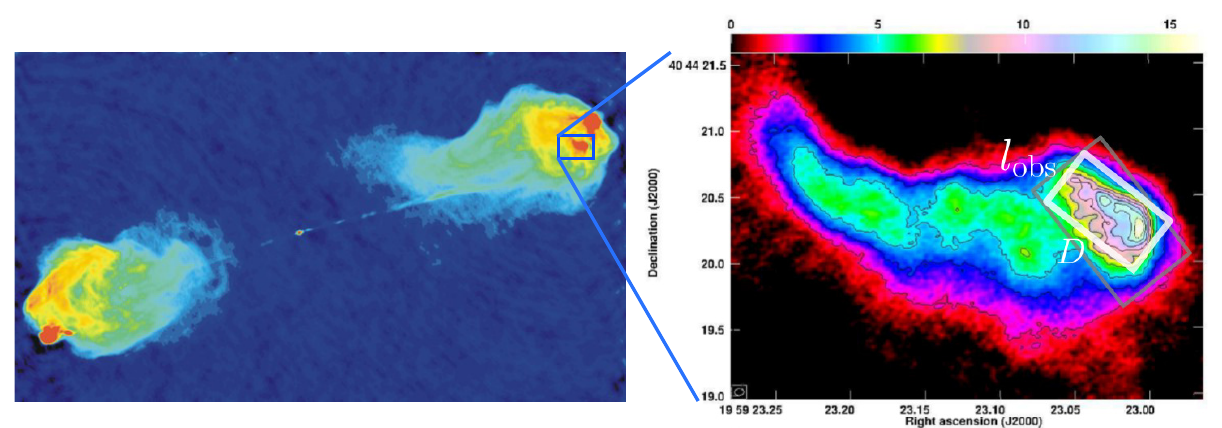
Figure 1. Left: Radiogalaxy Cygnus A at 5 GHz (courtesy of NRAO / AUI). The jets terminate at ∼ 60 kpc from the central source where the primary and secondary hotspots are detected. Right: Primary hotspot in the western lobe at 43 GHz, adapted from [11].